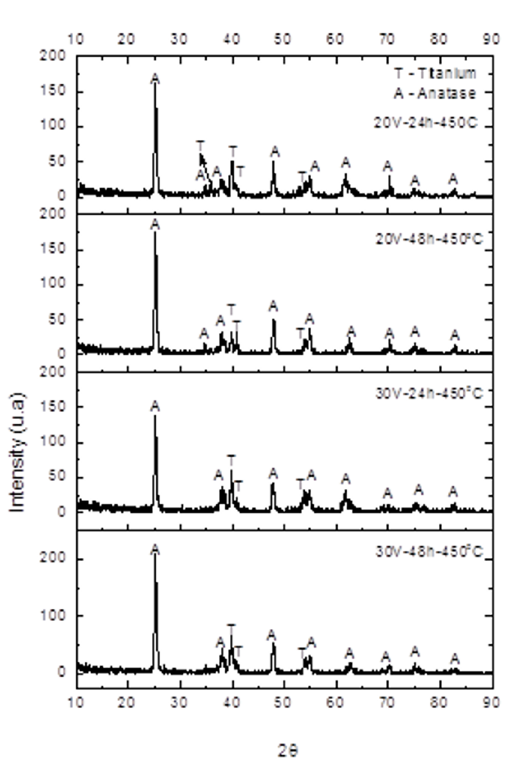
Figures 4. The X-ray diffraction patterns for the samples calcined at 600